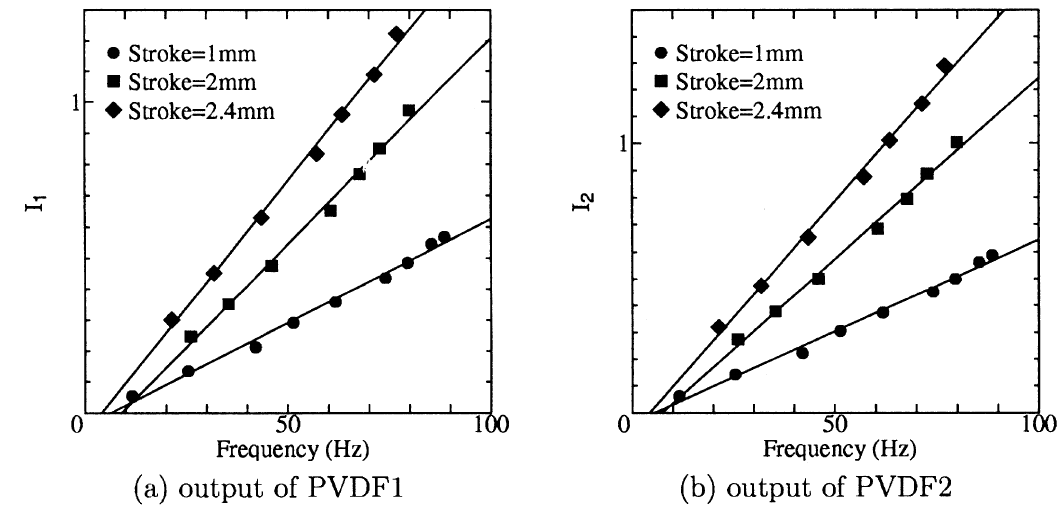
Fig. 3. Frequency responses of PVDF1 ( I 1 ) and PVDF2 ( I 2 ) on a plane plastic foam block with various